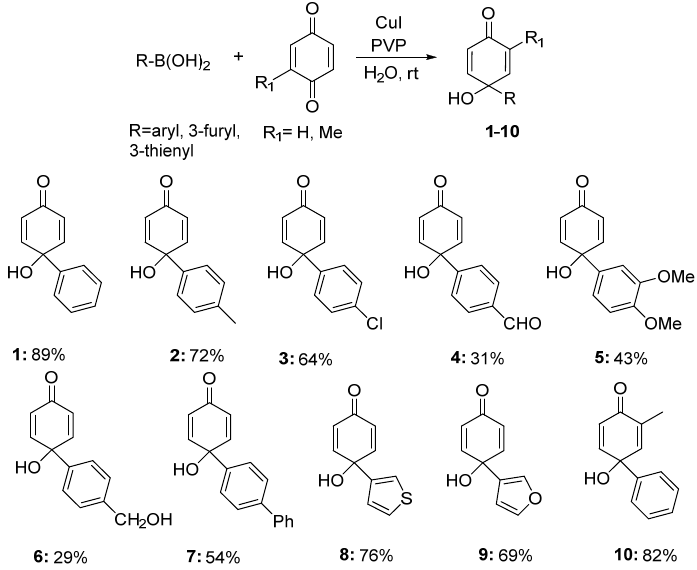
Figure 4. Synthesis of various p -quinols under optimized conditions. Reaction conditions: arylboronic acid (1 mmol), benzoquinone (1 mmol), CuI (0.1 mmol, 10 mol%), and PVP (10 mol%) in distilled water (4 mL) for 8 h, magnetic stirring 600 rpm, reaction shielded from light with aluminum foil. Yields in brackets provided for isolated products 1 – 10 .